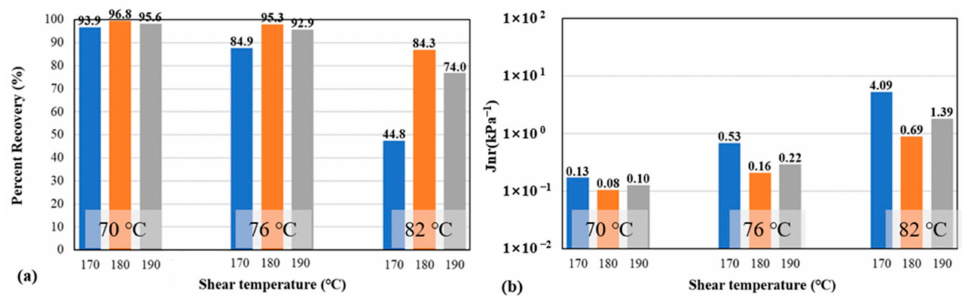
Figure 6. MSCR test results of SBS-modified asphalt under different shear temperatures ( a ) R, ( b )